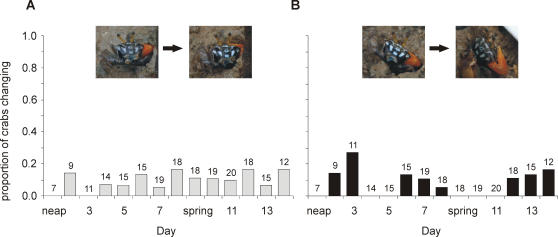
Colour change in Uca capricornis in relation to the semilunar cycle.The proportion of crabs that brightened (a), or darkened (b) on each day of the tidal cycle relative to the number of crabs active on that day, which is presented above each bar. Examples of a crabs brightening and darkening are presented in the appropriate graphs.